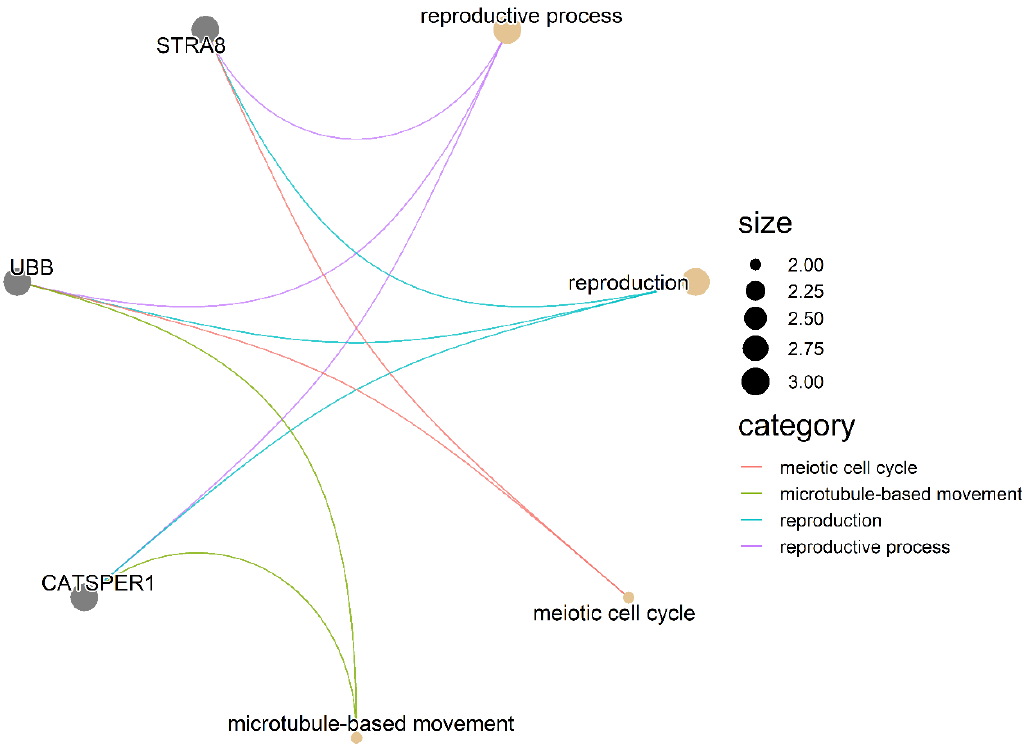
Figure 2. Gene network of biological processes for semen traits of candidate genes. Gray nodes represent candidate genes, yellow nodes represent biological processes, and different biological processes and candidate genes are connected by different colors.